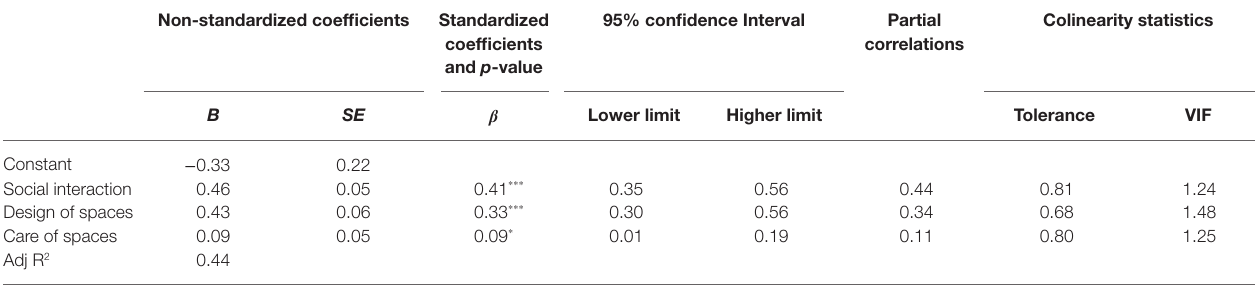
TABLE 7 | Output of the perceived environmental quality regression on perceived restorativeness—squares.